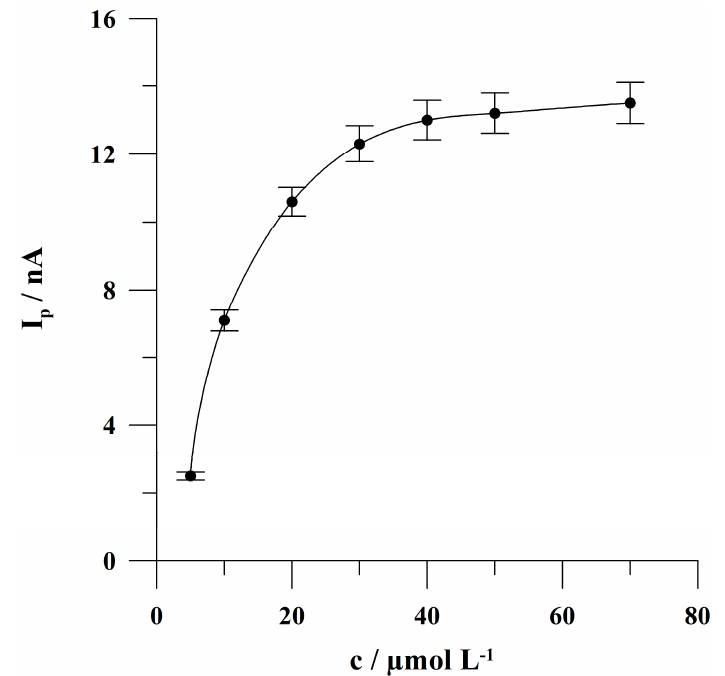
Figure 4. Effect of cupferron concentration on U(VI) signal. U(VI) concentration: 5 × 10 − 8 mol L − 1 . Accumulation conditions: − 0.7 V, 120 s. The error bars refer to the standard deviation (n = 3).